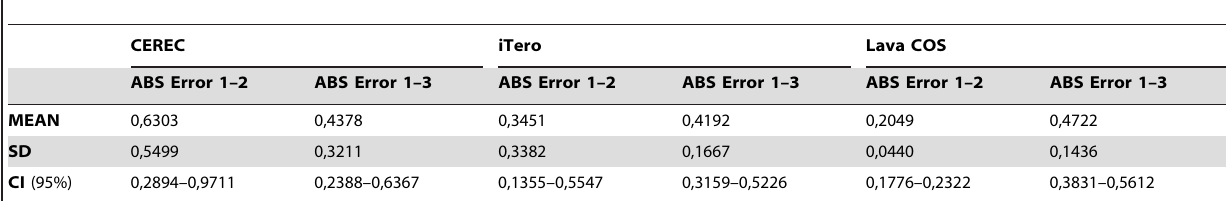
Table 2. Absolute errors in the angle between the cylinders in